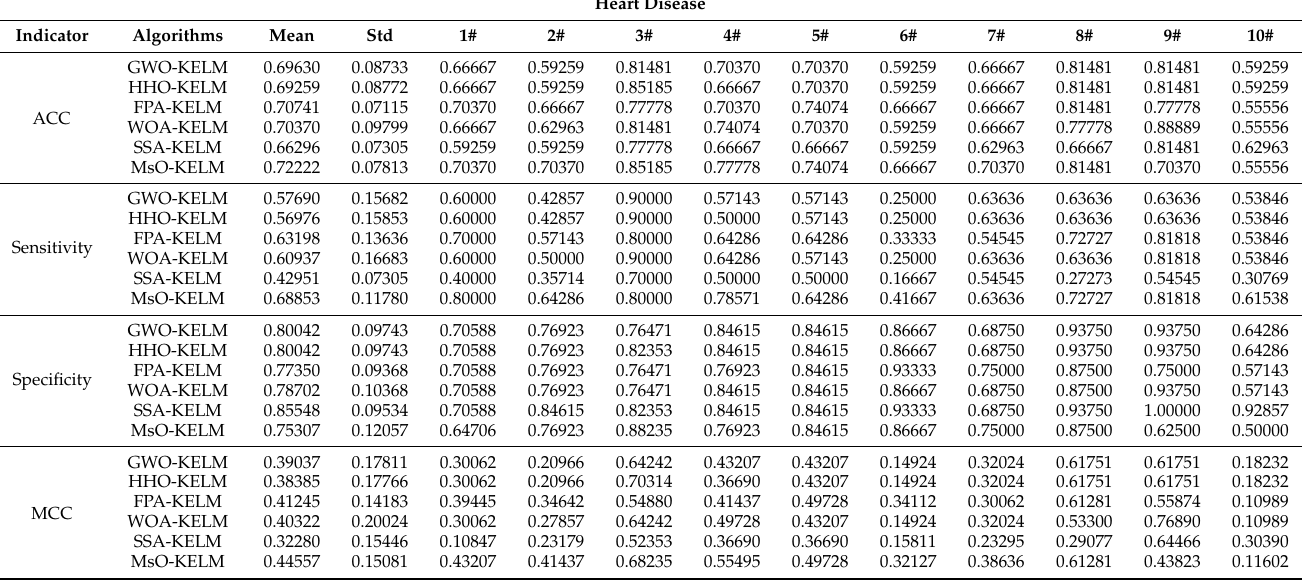
Table 9. The prediction results on disease dataset Heart Disease.